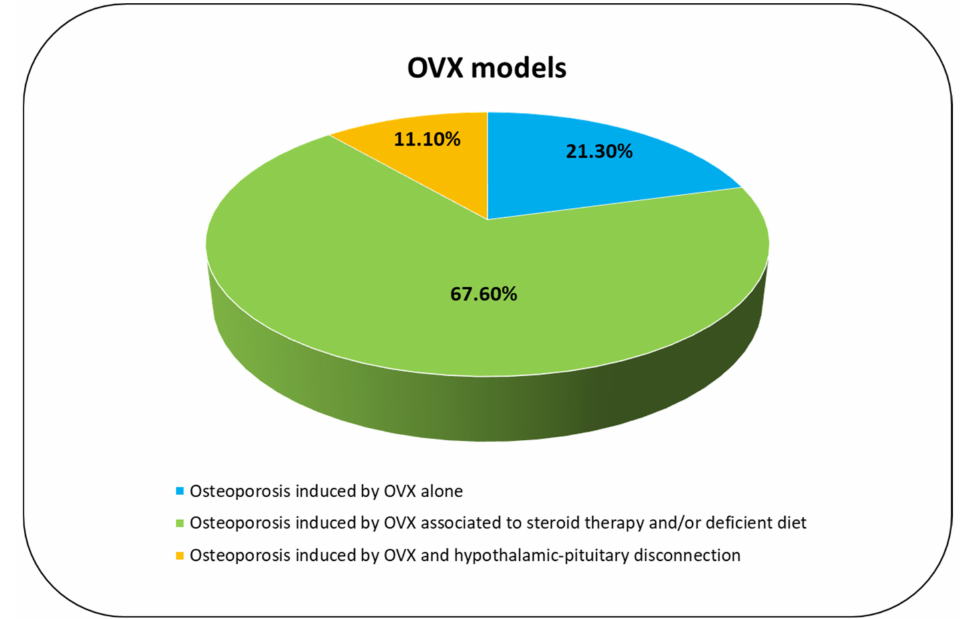
Figure 5. OVX models analyzed in this